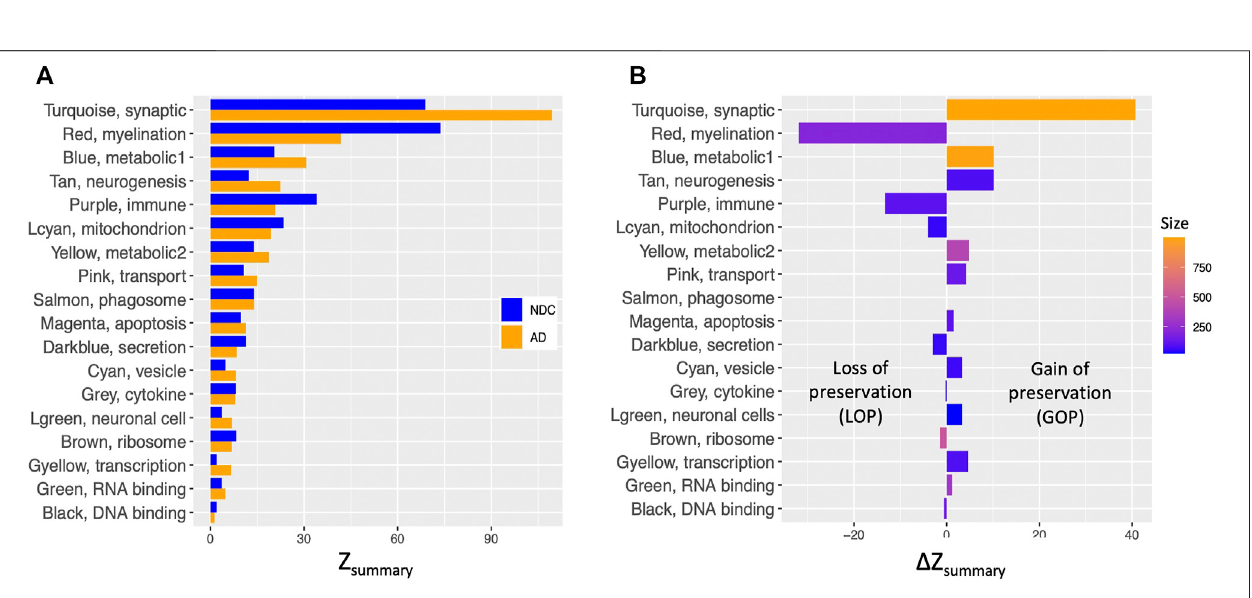
Frontiers in Genetics |